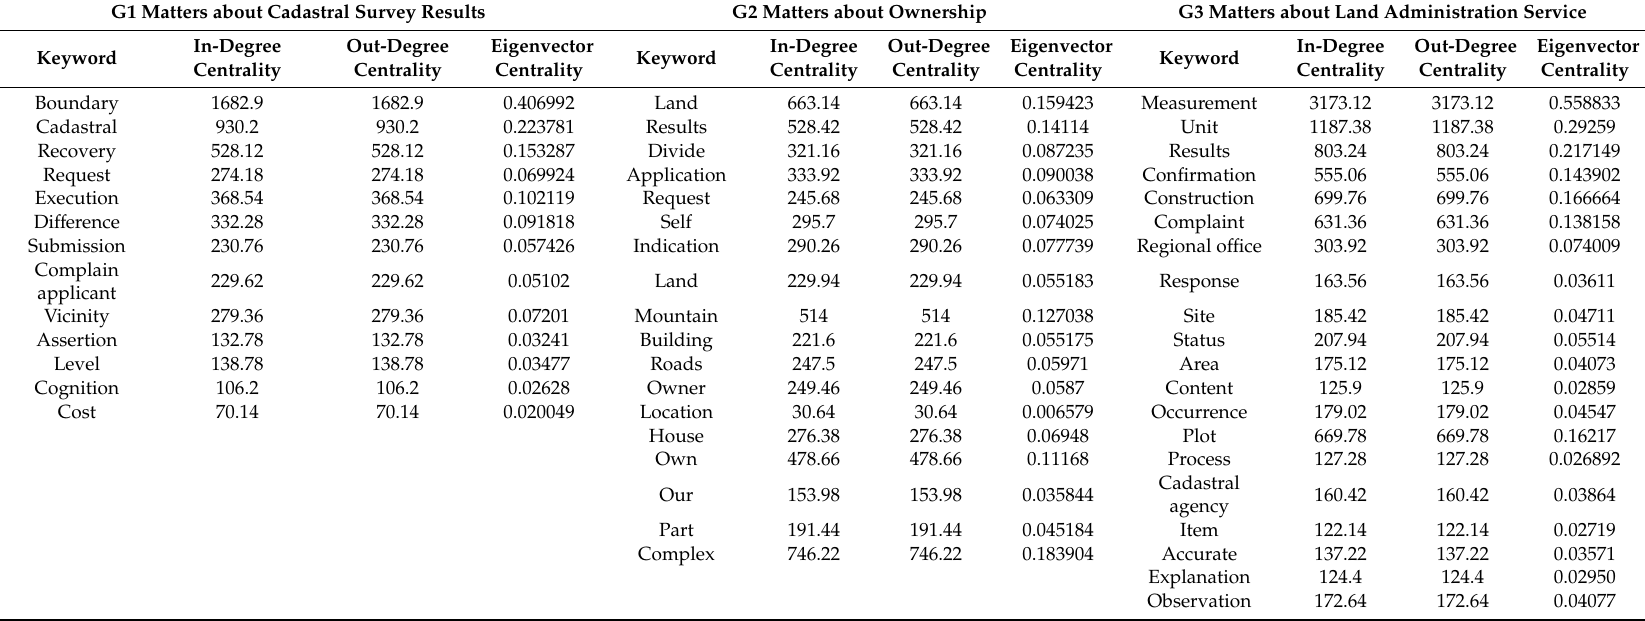
Table 2. Results of keywords network by